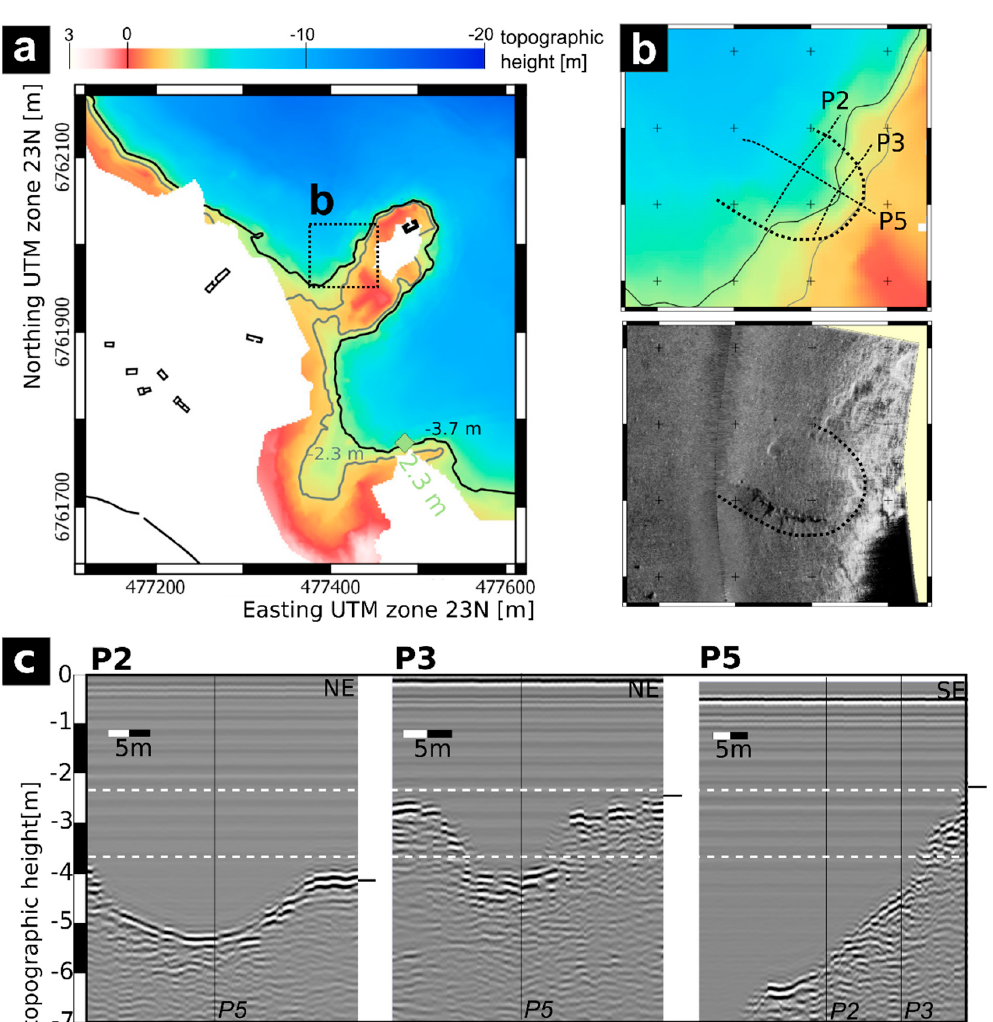
Figure 7. ( a ) Zoomed image of the peninsula (which today is an island) with remains of a stone building and the most probable harbour / landing site areas of the settlement. The black and grey lines indicate the estimated low tide and high tide around the year 1000. ( b ) Side-scan sonar image and bathymetry of a peculiar notch (dashed lines show sections of seismic profiles). The high scatter intensities to the right represent the slope to the present coastline. A peculiar feature interpreted as a potential protected anchorage or mooring place is the E–W directed narrow stripe of low backscatter intensity in the lower half of the image (indicated by the dotted line). ( c ) Seismic cross-sections of the highlighted feature.